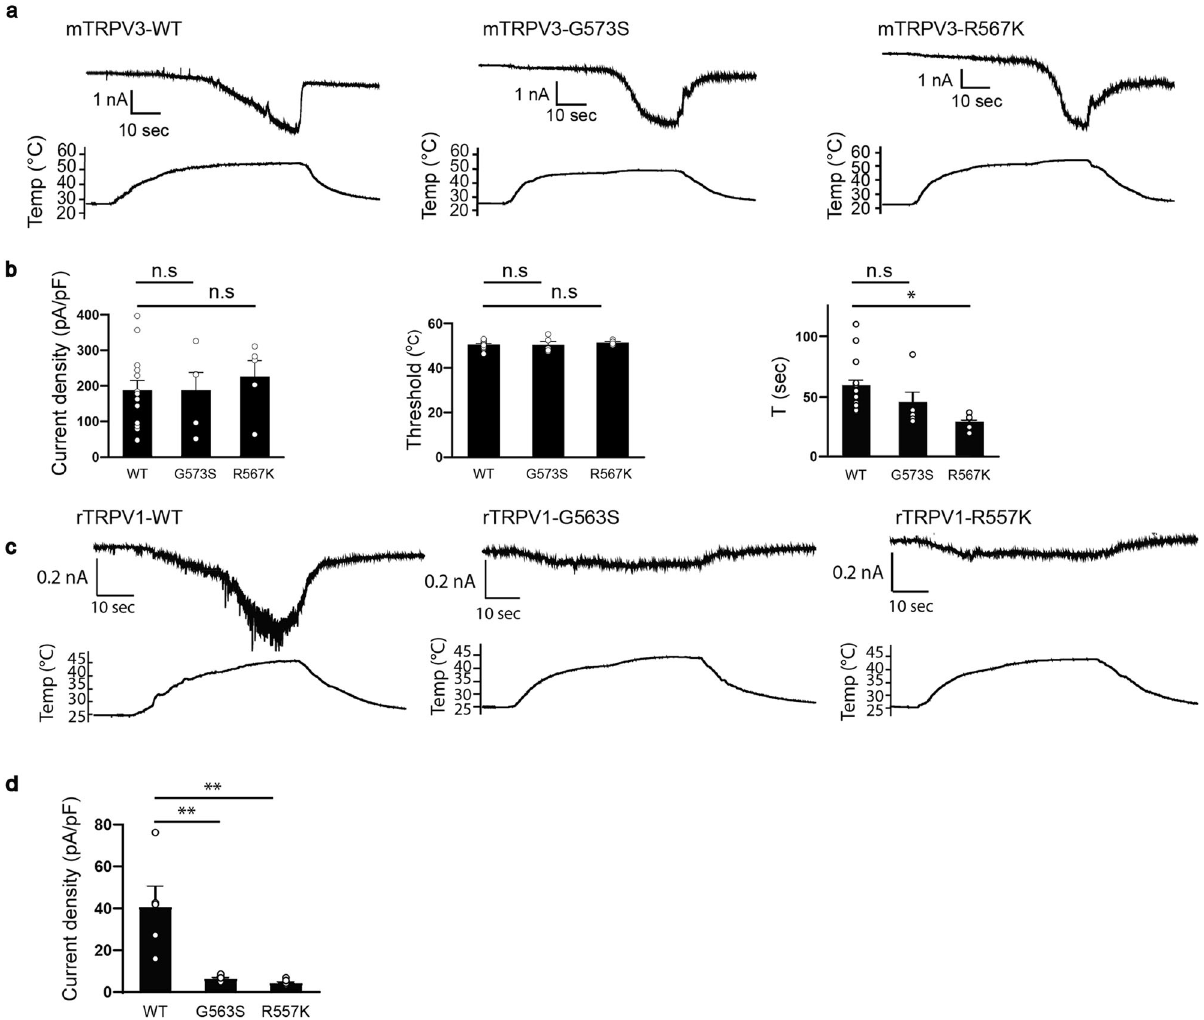
Fig. 6 Heat-evoked currents for WT and mutated mouse TRPV3 and rat TRPV1. a Representative current (upper) and temperature (lower) traces for HEK293T cells expressing WT, mTRPV3-G573S, or mTRPV3-R567K exposed to heat up to 53 °C. b Comparison of heat-evoked current densities